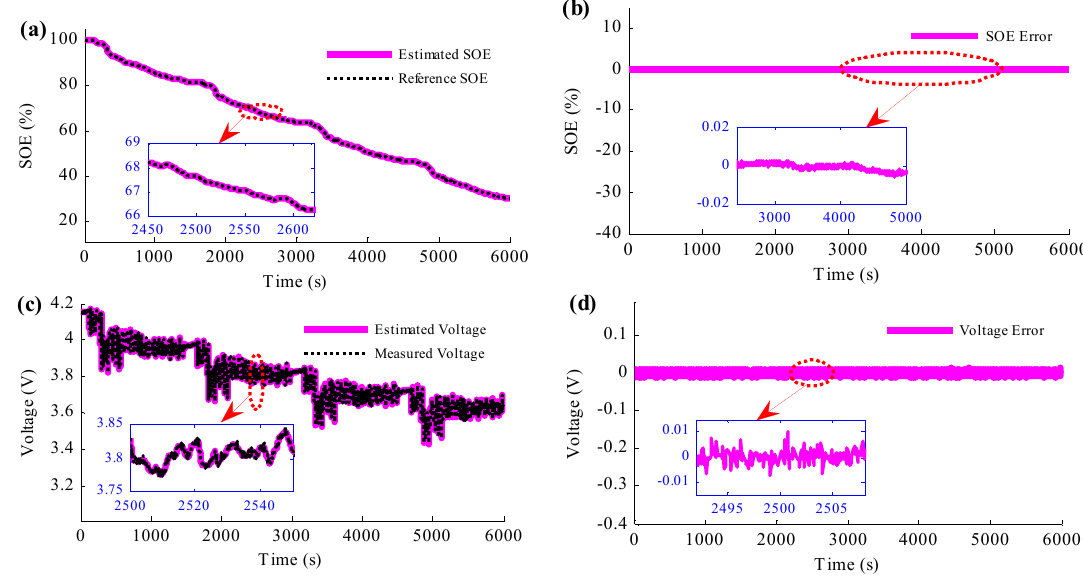
Figure 5. Simulation results when the current sensor works properly: ( a ) SOE estimation results; ( b ) SOE estimation error; ( c ) voltage results; ( d ) voltage estimation error.